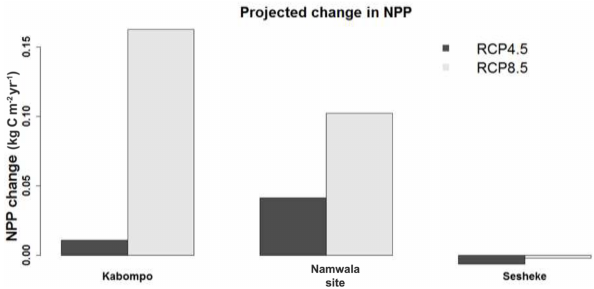
Figure 7. Projected changes in NPP at Kabompo, Namwala, and Sesheke resulting from combined changes in temperature, rainfall, CO 2 concentration, solar radiation, and number of wet days by the end of the 21st century (2070–2099) with reference to 1960–1989 as the